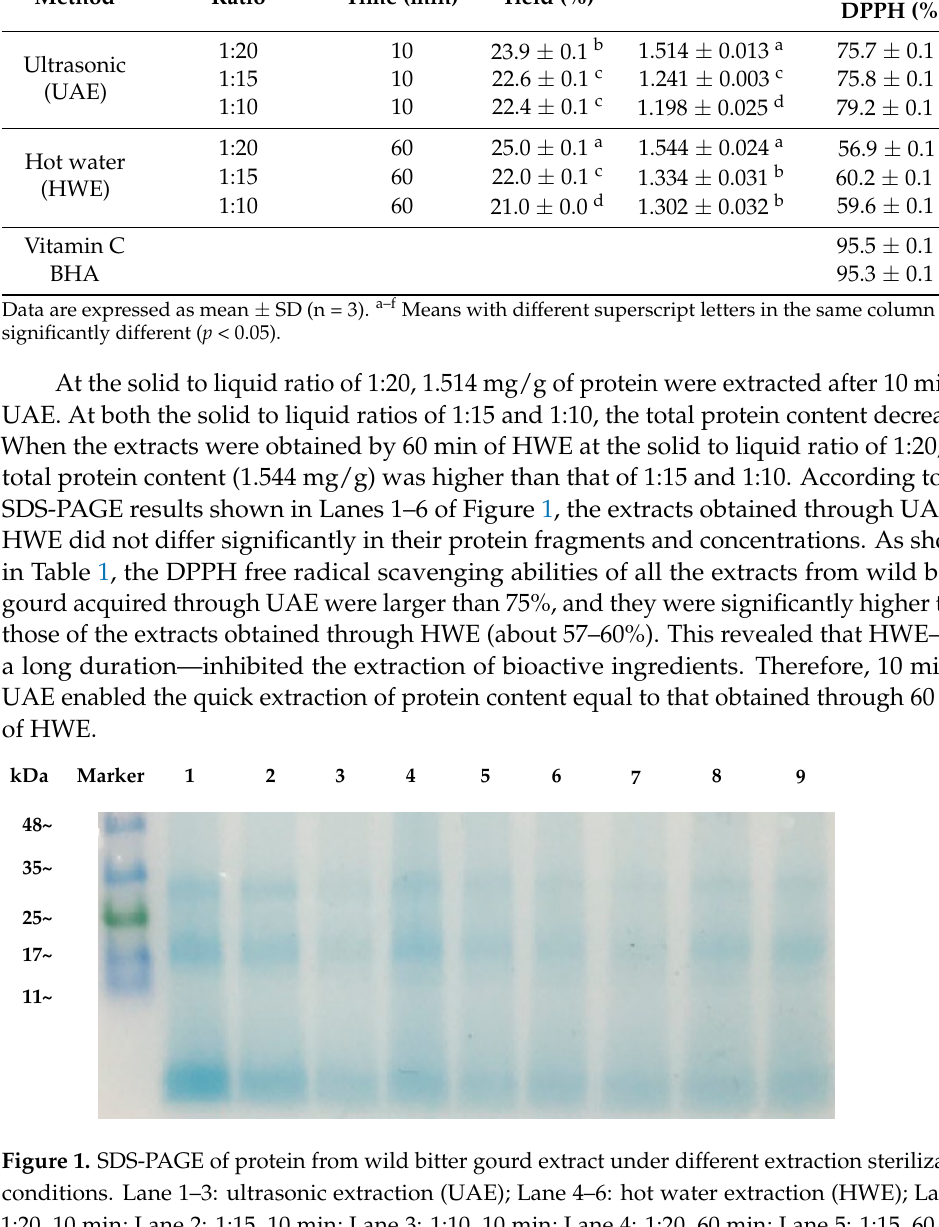
Table 1. Effect of ultrasonic extraction and hot water extraction conditions on yield, total protein, and antioxidant activity of wild bitter gourd.